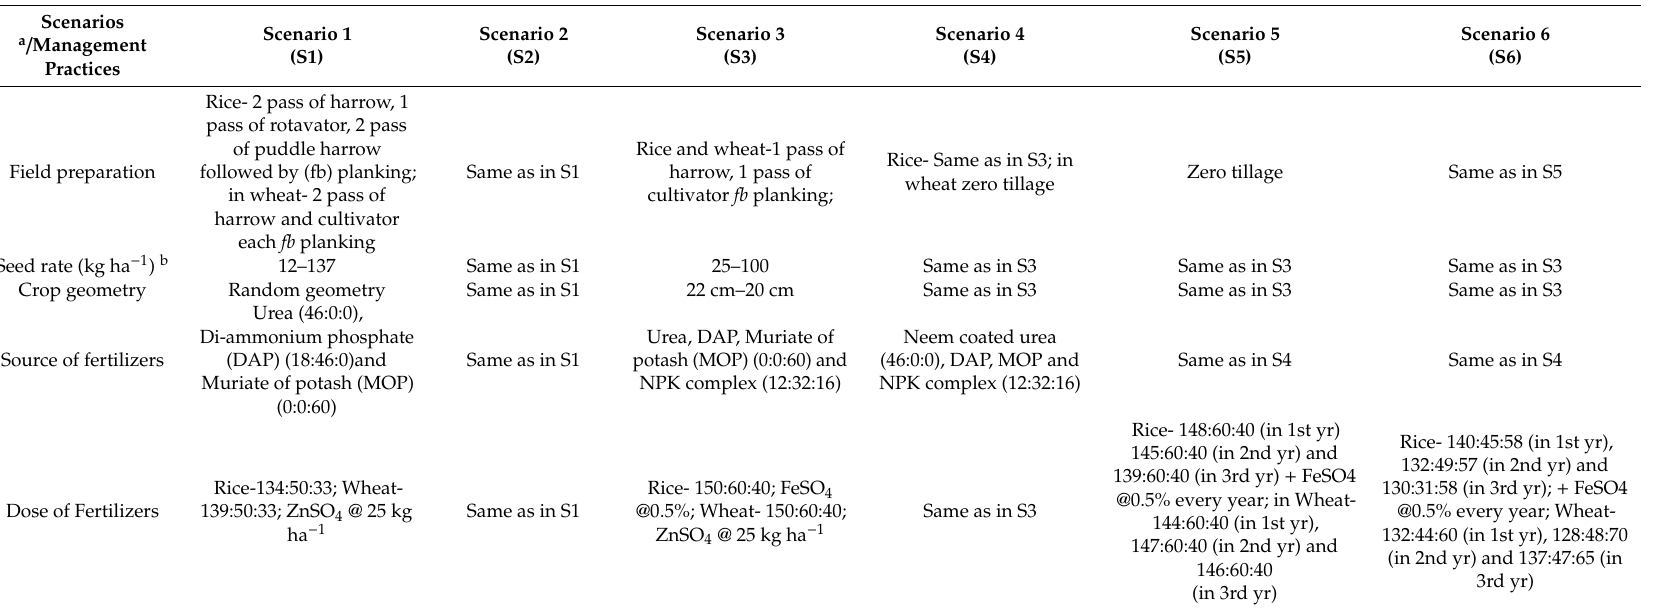
a Refer Table 1 for scenario description. b Seed treatment was done with Bavistin + Streptocycline @ 10 + 1 g 10 kg − 1